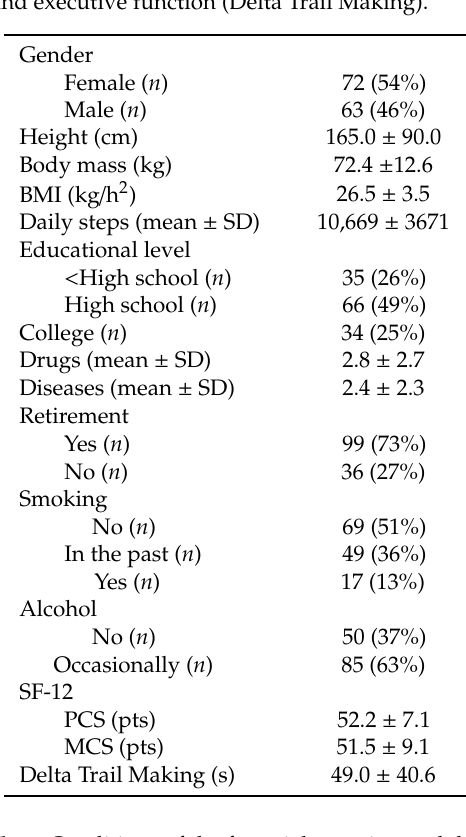
Table 2. Conditions of the factorial experimental